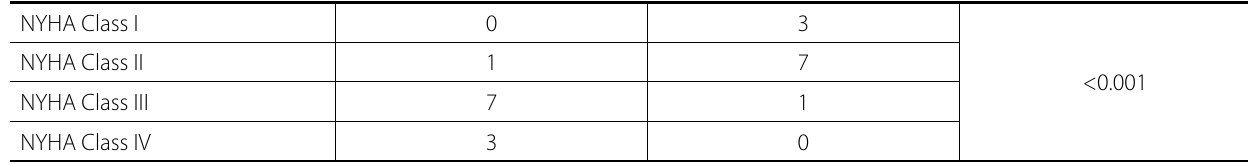
Table 4 . Statistical analyses of functional classification. NYHA Class